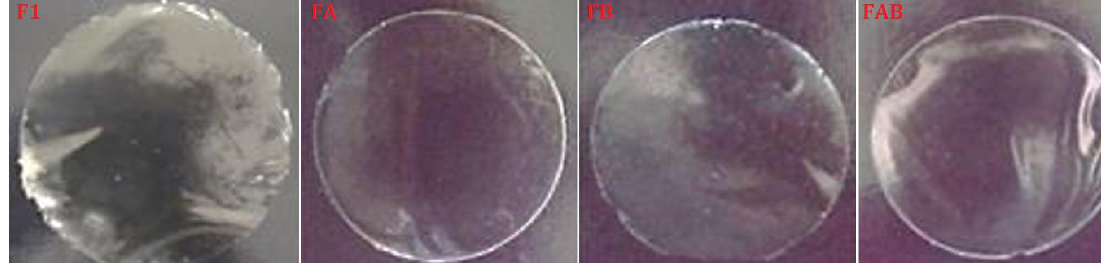
Figure 1. Diltiazem HCl mucoadhesive Buccal Film